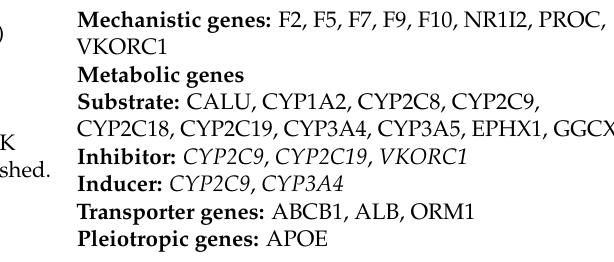
Molecular Formula: C 18 H 16 O